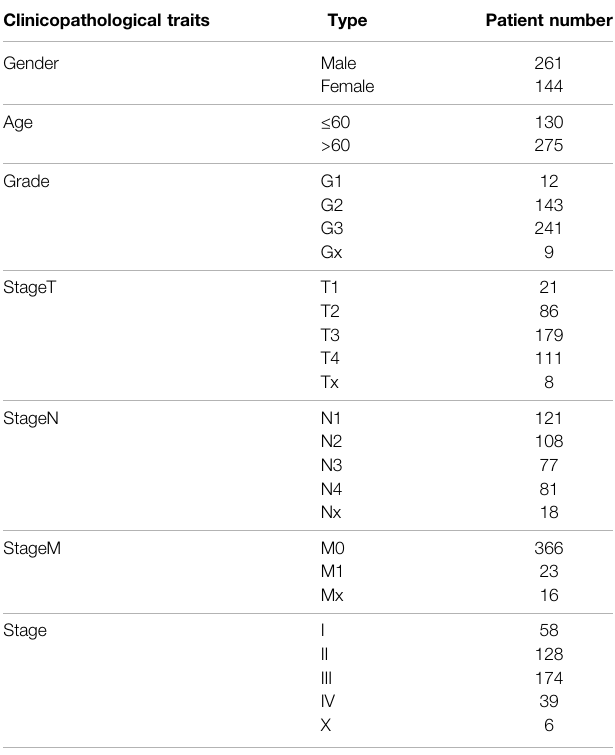
TABLE 1 | Clinicopathological information of the TCGA-STAD